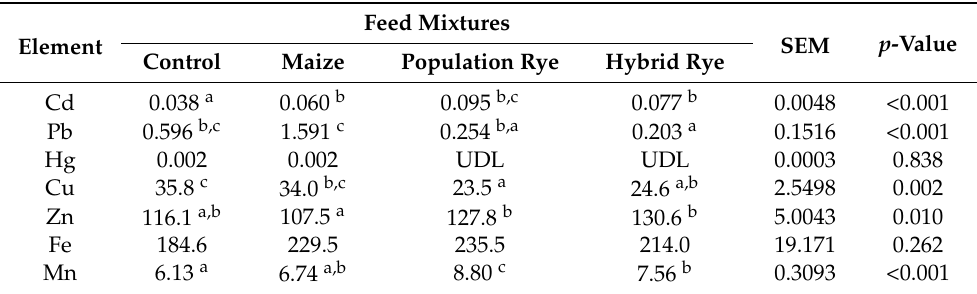
Table 8. The mean content of heavy metals (mg/kg dry tissue, b. wt.) in the kidneys of pigs fed control and experimental